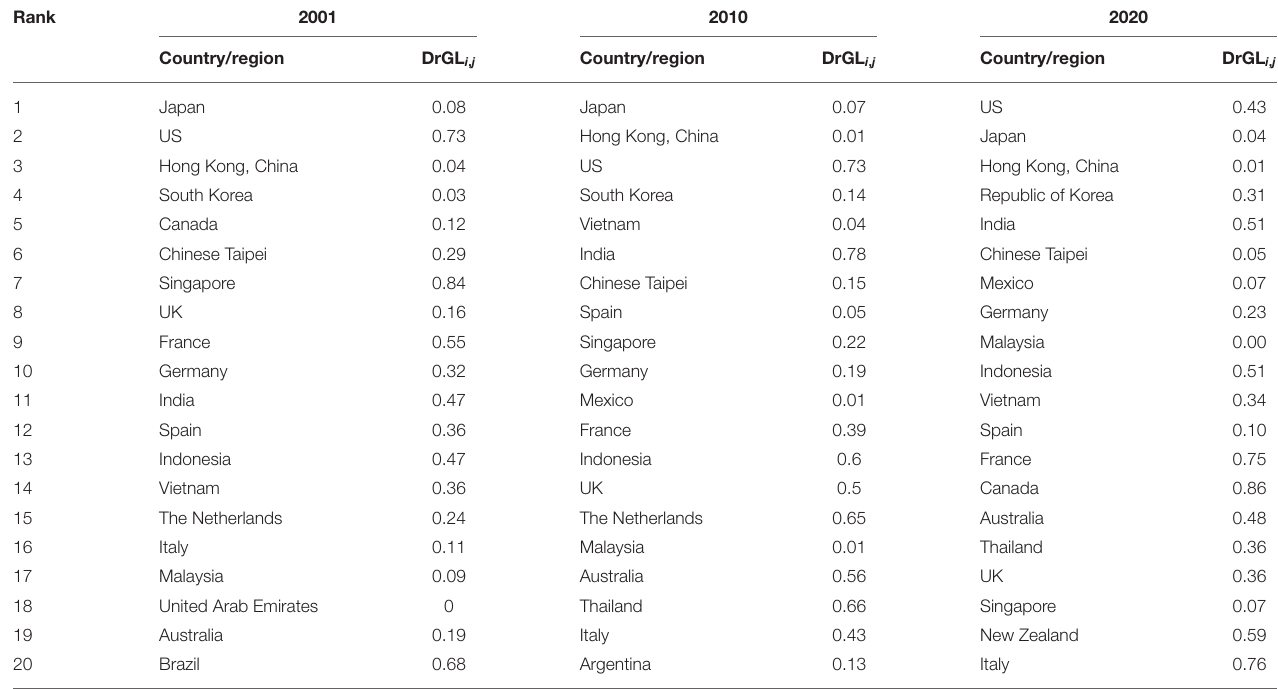
TABLE 6 | Interdependence between China and its top 20 trading partners in 2001, 2010, and 2020. Rank